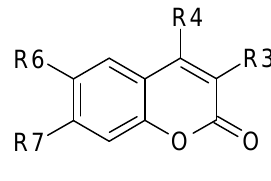
Table 1. All the molecules in the training and test set are shown. Test set molecules are given in bold